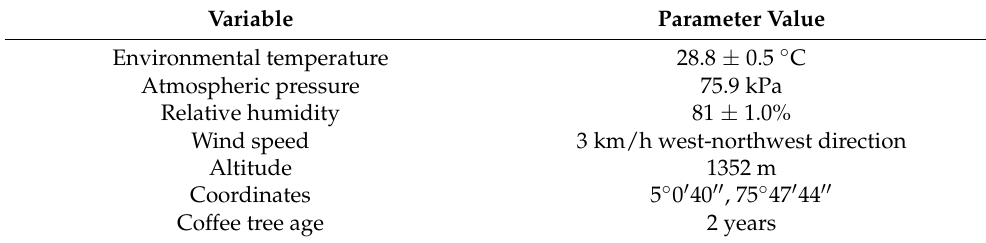
Table 1. Farm characterization